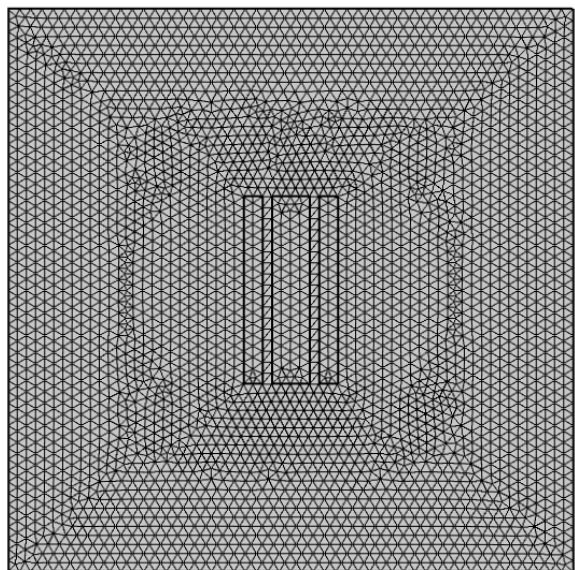
Figure 6. Meshing result.